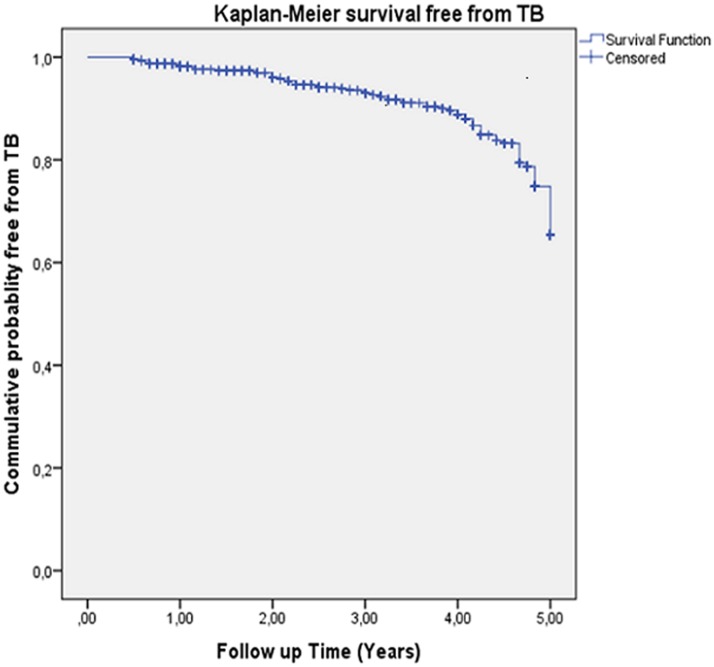
Kaplan Meier probability of TB-free survival (submitted as a separate file).